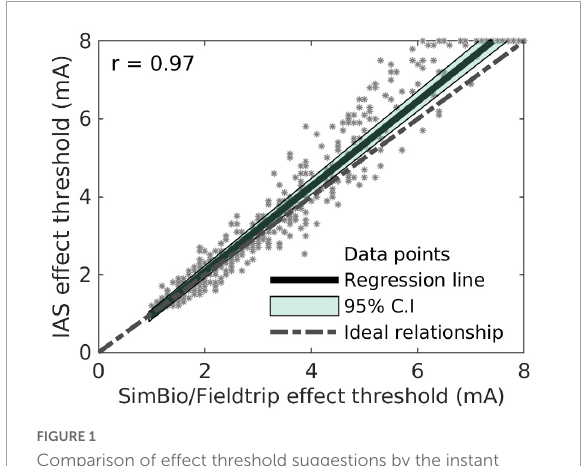
FIGURE1 Comparison of effect threshold suggestions by the instant analytical spheres (IAS) algorithm and by the SimBio/FieldTrip algorithm.